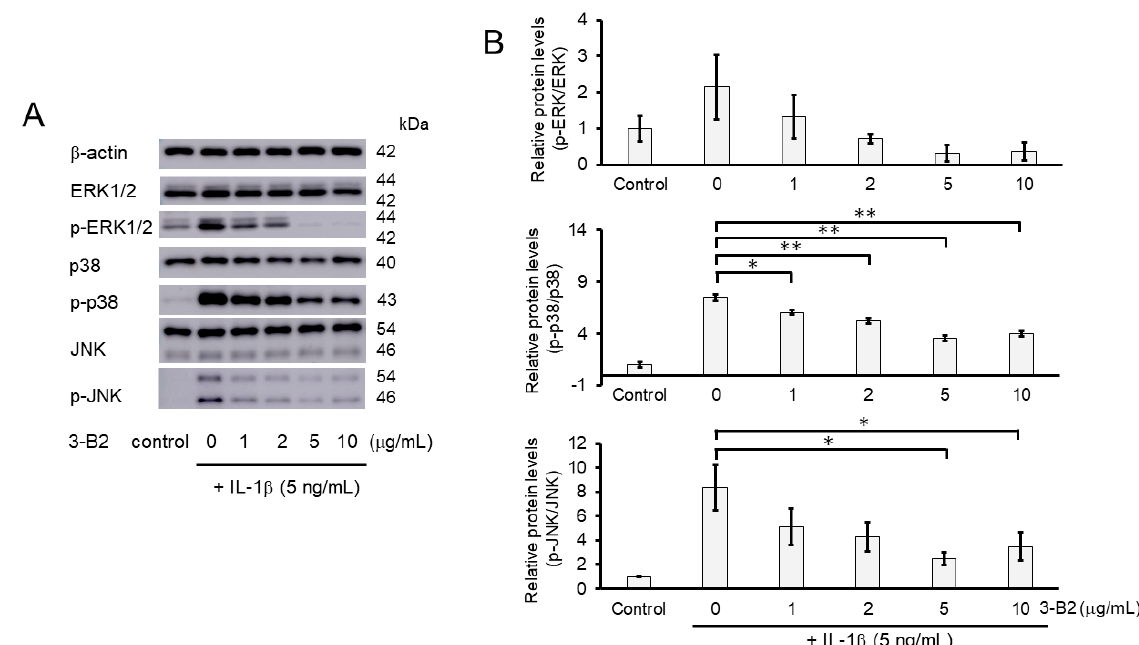
Figure 10. Activation of the MAPK signaling pathway was suppressed by 3-B2 in a concentration- dependent manner. ( A ) Western blot analysis of the relative phosphorylation levels of Erk1/2, p38, and JNK after 3-B2 and IL-1 β treatment. Cells were treated with 3-B2 at various concentrations (0, 1, 2, 5, and 10 µ g/mL) and then induced with 5 ng/mL IL-1 β for 20 min. 3-B2 reduced the phosphorylation of Erk1/2, p38, and JNK in a dose-dependent manner. ( B ) Quantitative estimation of the relative phosphorylated protein levels of Erk1/2, p38, and JNK after 3-B2 and IL-1 β treatment. Values represent mean ± SE ( n = 3 per group). * p < 0.05 and ** p < 0.01,